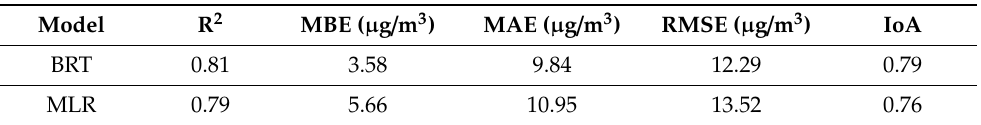
Table 2. Statistical indicators of the BRT and MLR models performances for the validation data set. Legend: R 2 = coe ffi cient of determination, MBE = mean bias error, MAE = mean absolute error, RMSE = root men square error and IoA = index of agreement.